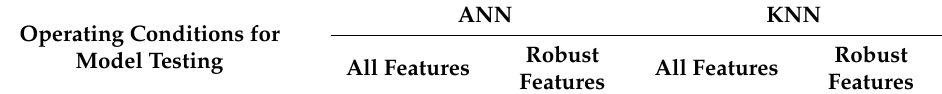
Table 2. Performance of AI models trained at minimum speed and load (600 rpm and 0 Nm